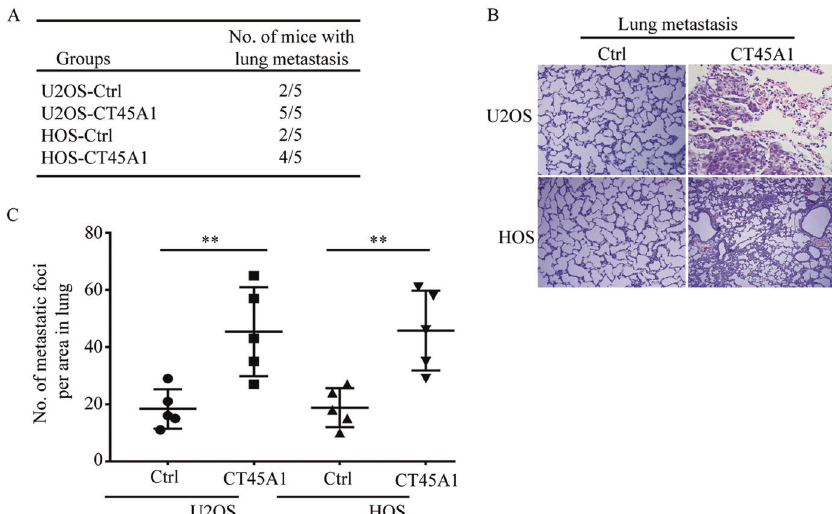
Fig. 3 CT45A1 promotes the metastasis of osteosarcoma cells in vivo. A The number of mice injected with U2OS and HOS cells showing that CT45A1 overexpression exhibited distant metastasis. B Hematoxylin and eosin staining for metastatic foci in lung injected with U2OS and HOS cells with CT45A1 overexpression. Scale bars: 200 μ m. C Statistic analysis of the number of metastatic foci in the lungs injected with U2OS and HOS cells with CT45A1 overexpression. ** P < 0.01, compared to the